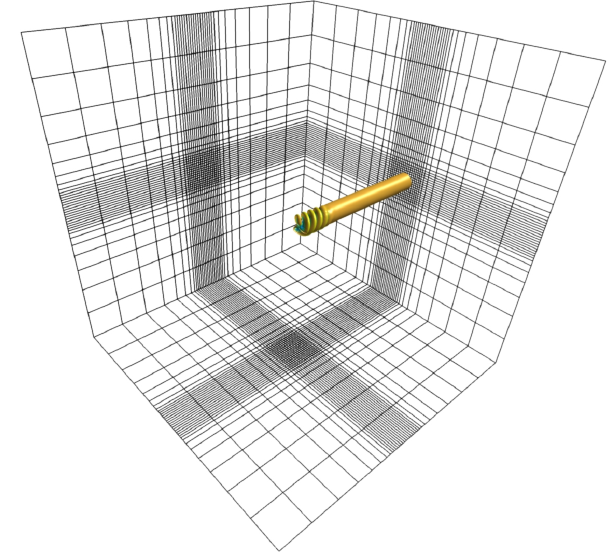
Figure 2. Numerical box domain with a structured mesh and uni- form spacing around the rotor at its centre. Only every eighth grid point is shown.